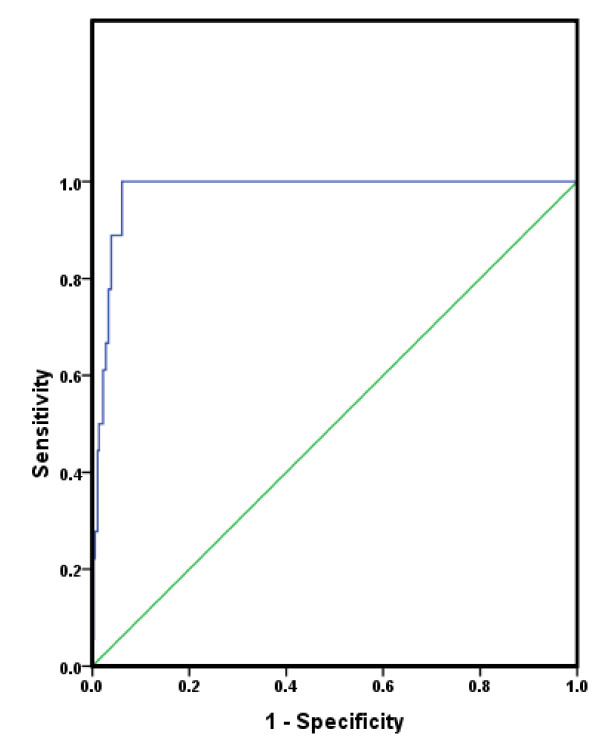
Receiver operating characteristic curve for the continuous metabolic syndrome score as a predictor of metabolic syndrome among 7-9 year old boys and girls. AUC = 0.978 (0.957-0.990, 95% confidence intervals).